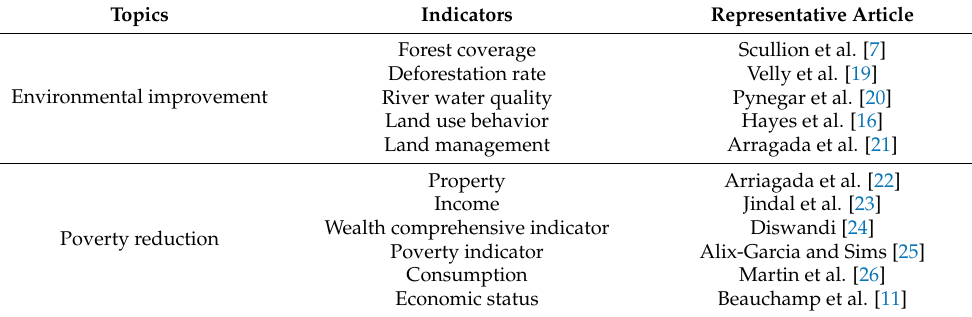
Table 1. Indicators used in the literature on environmental improvement and poverty reduction effects of